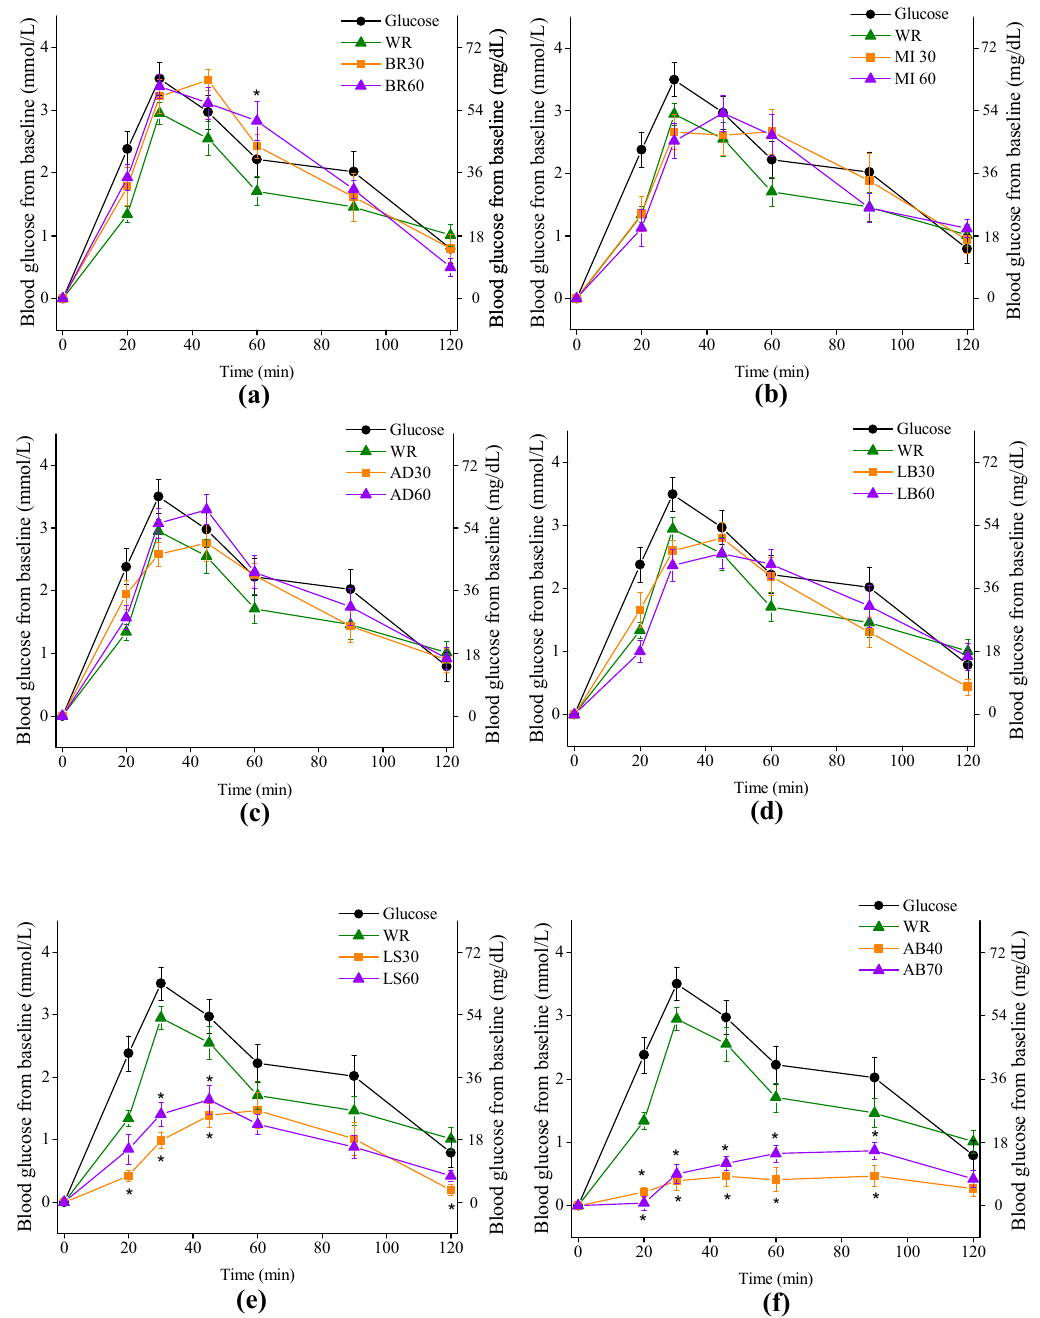
Figure 3. Blood glucose changes from baseline for test foods. WR, white rice cooked for 30 min; ( a ) waxy black rice cooked for 30 min (BR30), waxy black rice cooked for 60 min (BR60); ( b ) millet cooked for 30 min (MI30), millet cooked for 60 min (MI60); ( c ) adlay cooked for 30 min (AD30), adlay cooked for 60 min (AD60); ( d ) dried lily bulb cooked for 30 min (LB30), dried lily bulbs cooked for 60 min (LB60); ( e ) lotus seed cooked for 30 min (LS30), lotus seeds cooked for 60 min (LS60) ( f ) adzuki bean cooked for 40 min (AB40), adzuki bean cooked for 70 min (AB70). Values are the mean changes in blood glucose levels from baseline, n = 10, with their standard errors represented by vertical bars. Differences between test foods and white rice are shown (* p < 0.05).